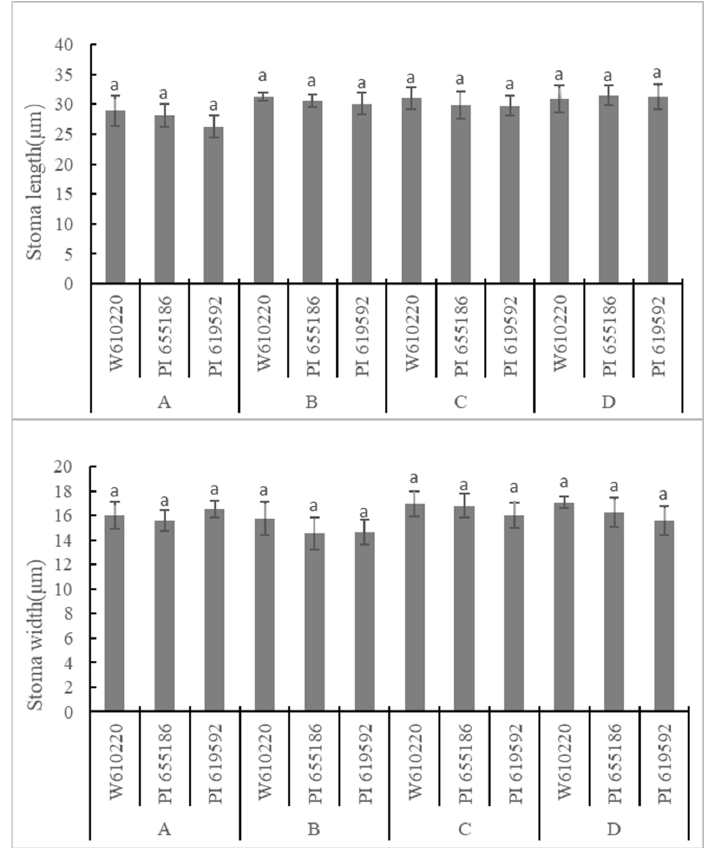
Figure 4. The difference of stoma length and width in awns of three accessions at four developmental stages. W610220, long awn, PI 655186, medium awn, PI 619592, short awn: (A) booting stage; (B) heading stage; (C) flowering stage; and (D) maturity stage. Error bars represent mean ± standard deviation. Different normal letters mean significant differences among different treatments at 0.05 level.